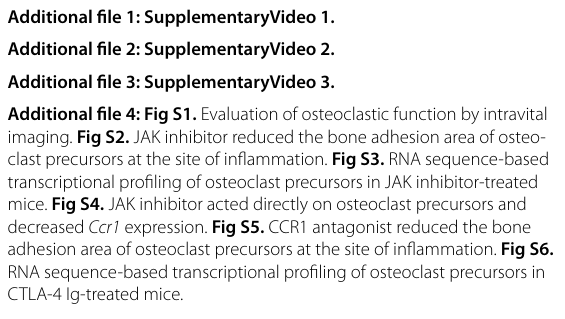
Additional file 4: Fig S1. Evaluation of osteoclastic function by intravital imaging. Fig S2. JAK inhibitor reduced the bone adhesion area of osteo- clast precursors at the site of inflammation. Fig S3. RNA sequence-based transcriptional profiling of osteoclast precursors in JAK inhibitor-treated mice. Fig S4. JAK inhibitor acted directly on osteoclast precursors and decreased Ccr1 expression. Fig S5. CCR1 antagonist reduced the